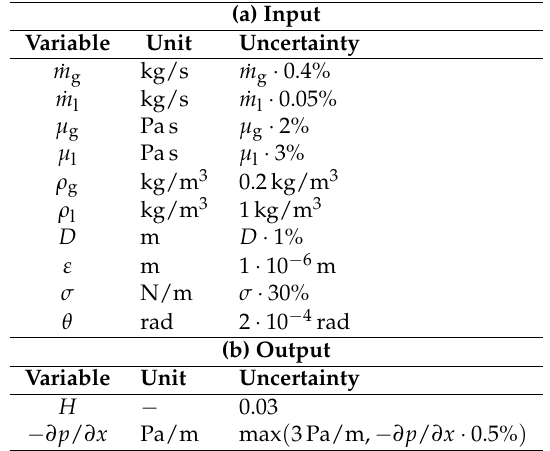
Table 2. Uncertainty in the model variables given as one standard